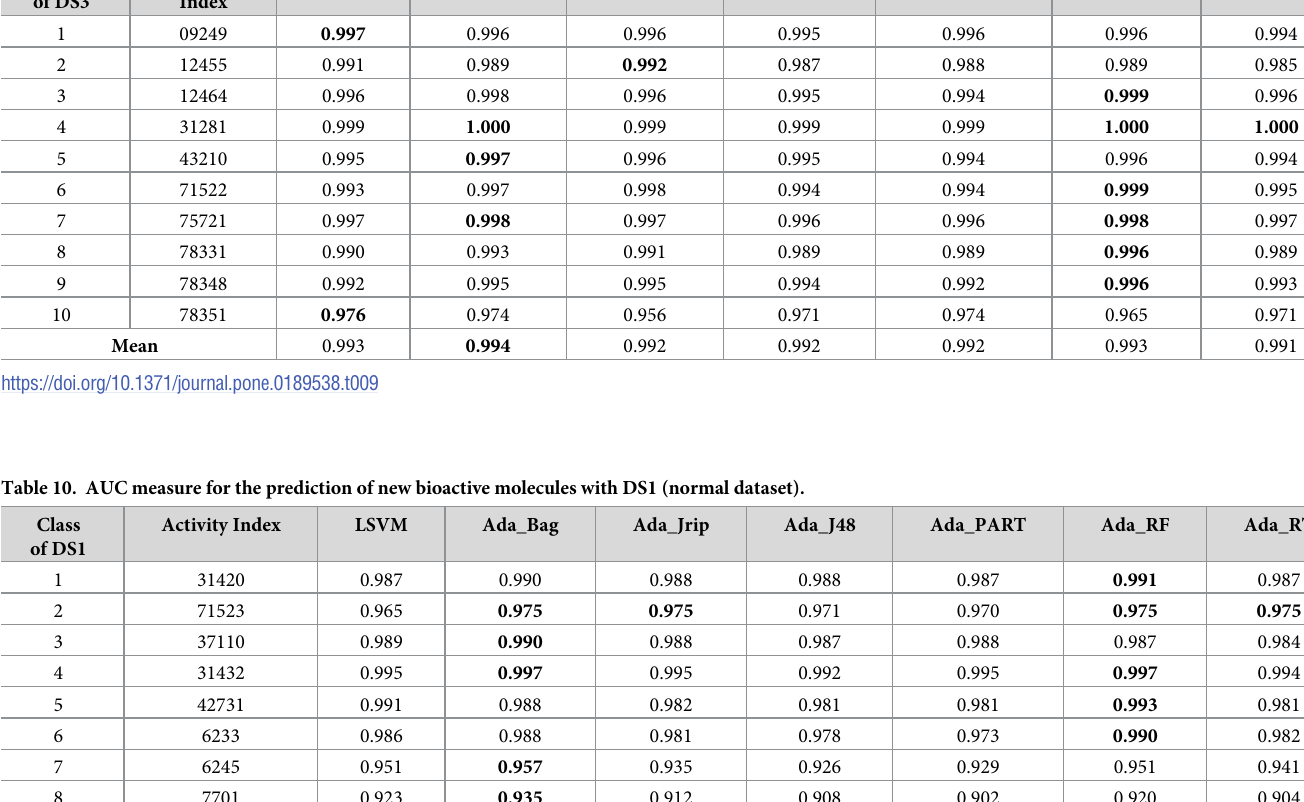
Table 9. Specificity measure for the prediction of new bioactive molecules with DS3 (heterogeneous). Class of DS3